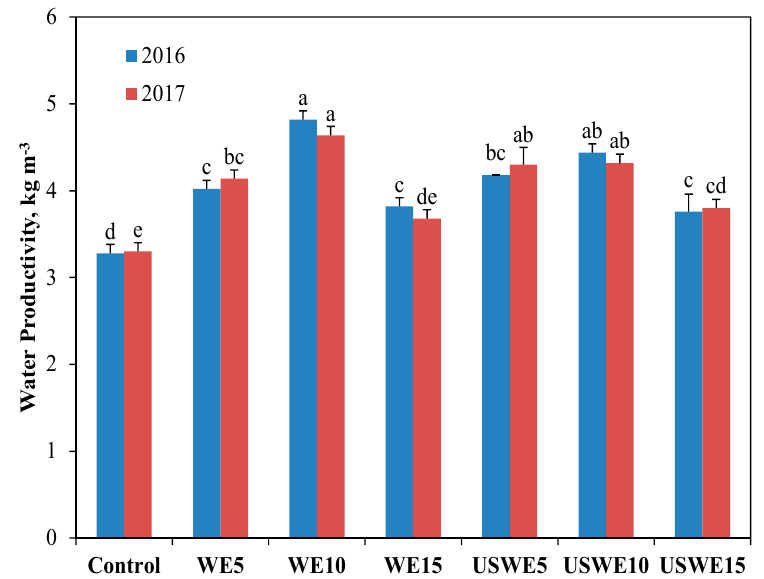
Figure 4. Water productivity (kg m − 3 ) of Jew’s Mallow as a function of water extract (WE) and ultrasound-assisted water extract (USWE) treatments in the 2016 and 2017 growing seasons. Different letters (a, b, etc.) above bars indicate a significant difference among treatments in each season. Table 3. Effects of water extract (WE) and Ultrasound-Assisted Water Extraction (USWE) on chlorophyll ‘a’, chlorophyll ‘b’, and carotene concentrations in Jew’s Mallow during the 2016 and 2017 growing seasons.